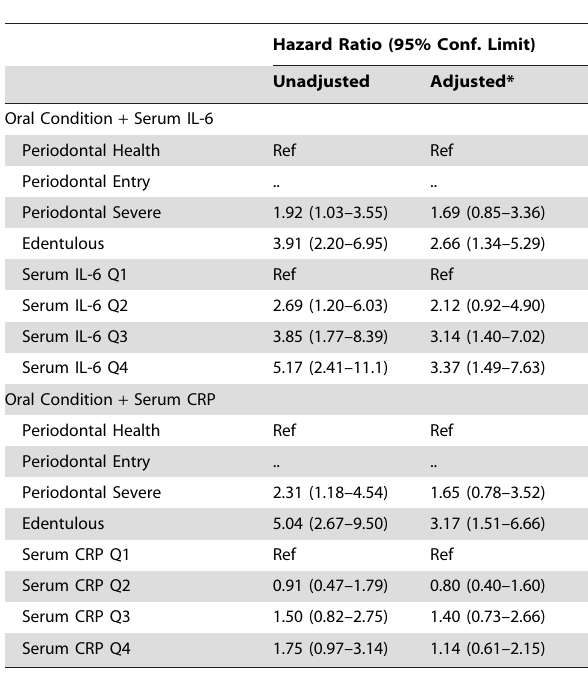
Table 6. Quartiles of Serum Biomarkers by COPD Related Events.